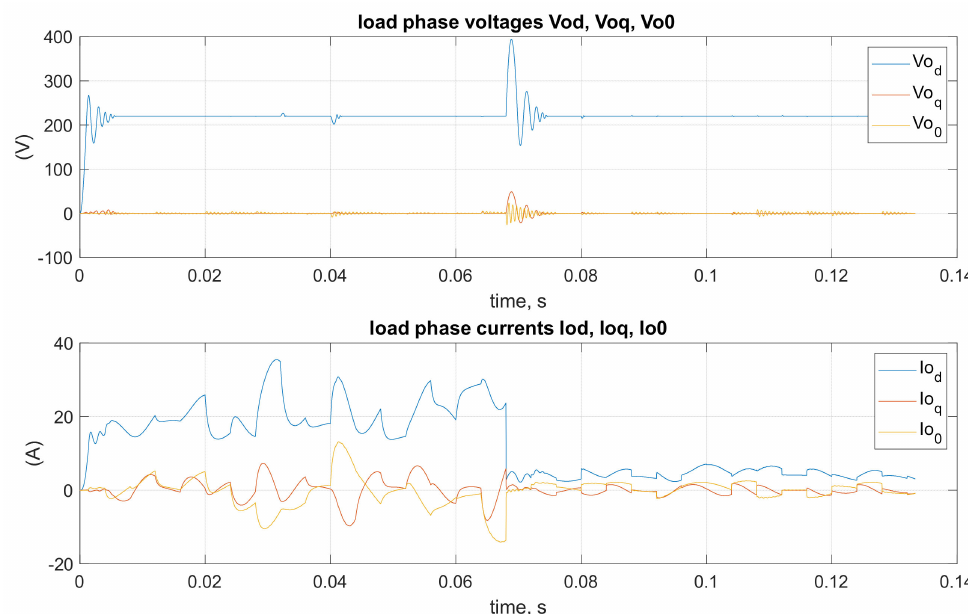
Figure 12. Load voltage V o maintaining the symmetry with a delay, as a result of limitations during a steep drop in load in Figure 9, expressed by the current I g .